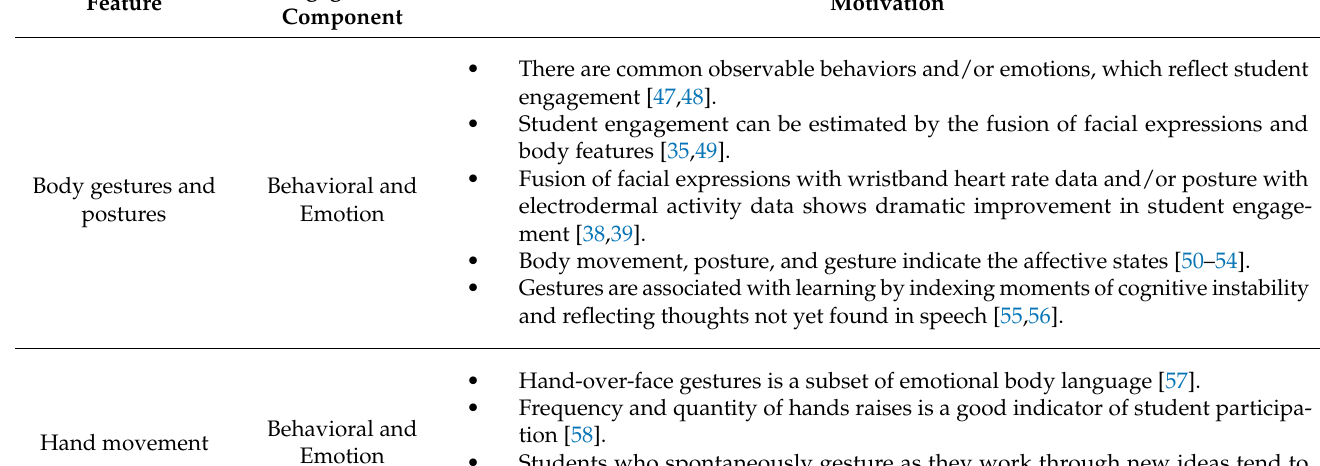
Table 2. Features of interest along with motivating literature.